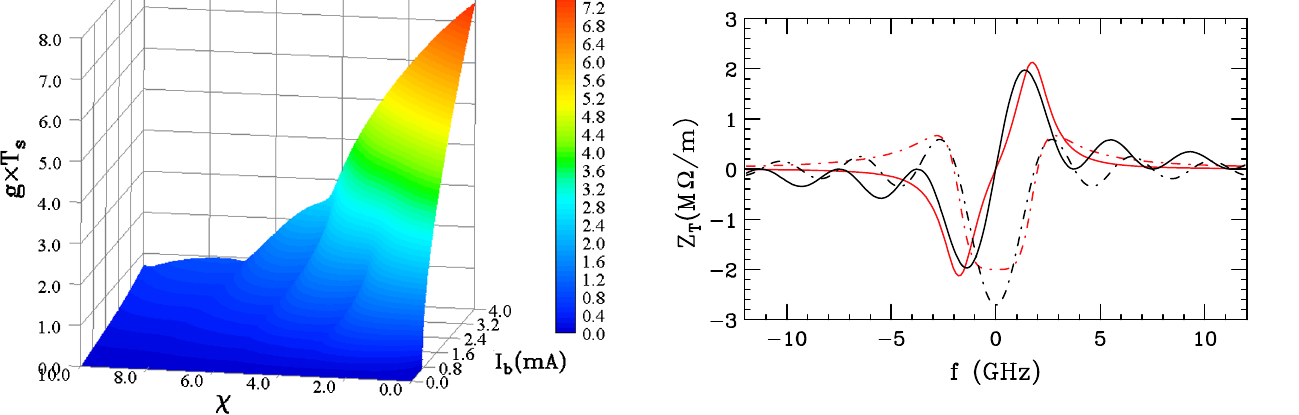
FIG. 19. The three-dimensional contour plot of the growth factor g × T as a function of ϒ and χ at the rms bunch length of s 2 cm in the LEP resonator model for the Vlasov analysis with the Gaussian bunch distribution.